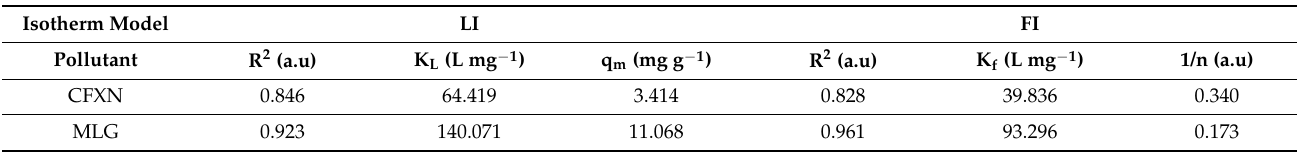
Table 1. The LI and FI parameters for the adsorption of CFXN and MLG on the ball-mill-fabricated CNPs at 25 ◦ C using concentration ranges of 10 to 50 mg L − 1 and 25 to 100 mg L − 1 for CFXN and MLG, respectively.